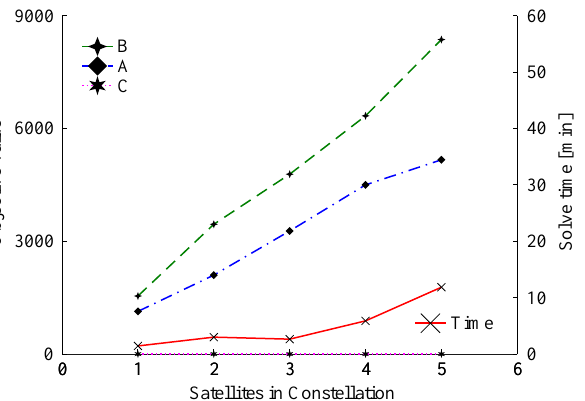
Figure 4. Collective (A) and individual (B) task objective values and respective solving time for five constellation sizes—from one to five satellites.